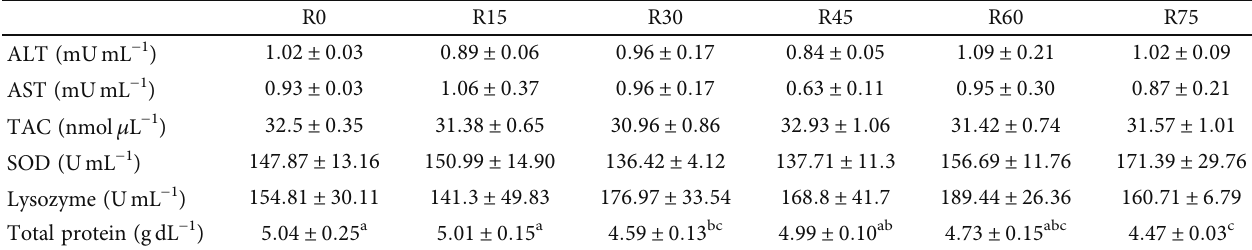
Table 6: Serum biochemical parameters of Japanese eel fed with di ff erent replacement levels of